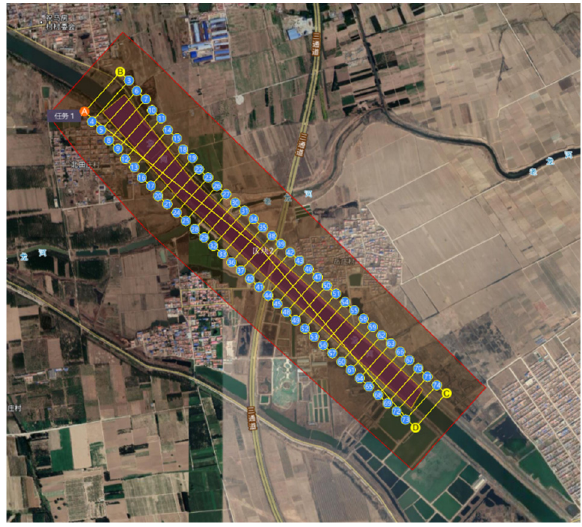
Figure 2. Distribution of survey area.